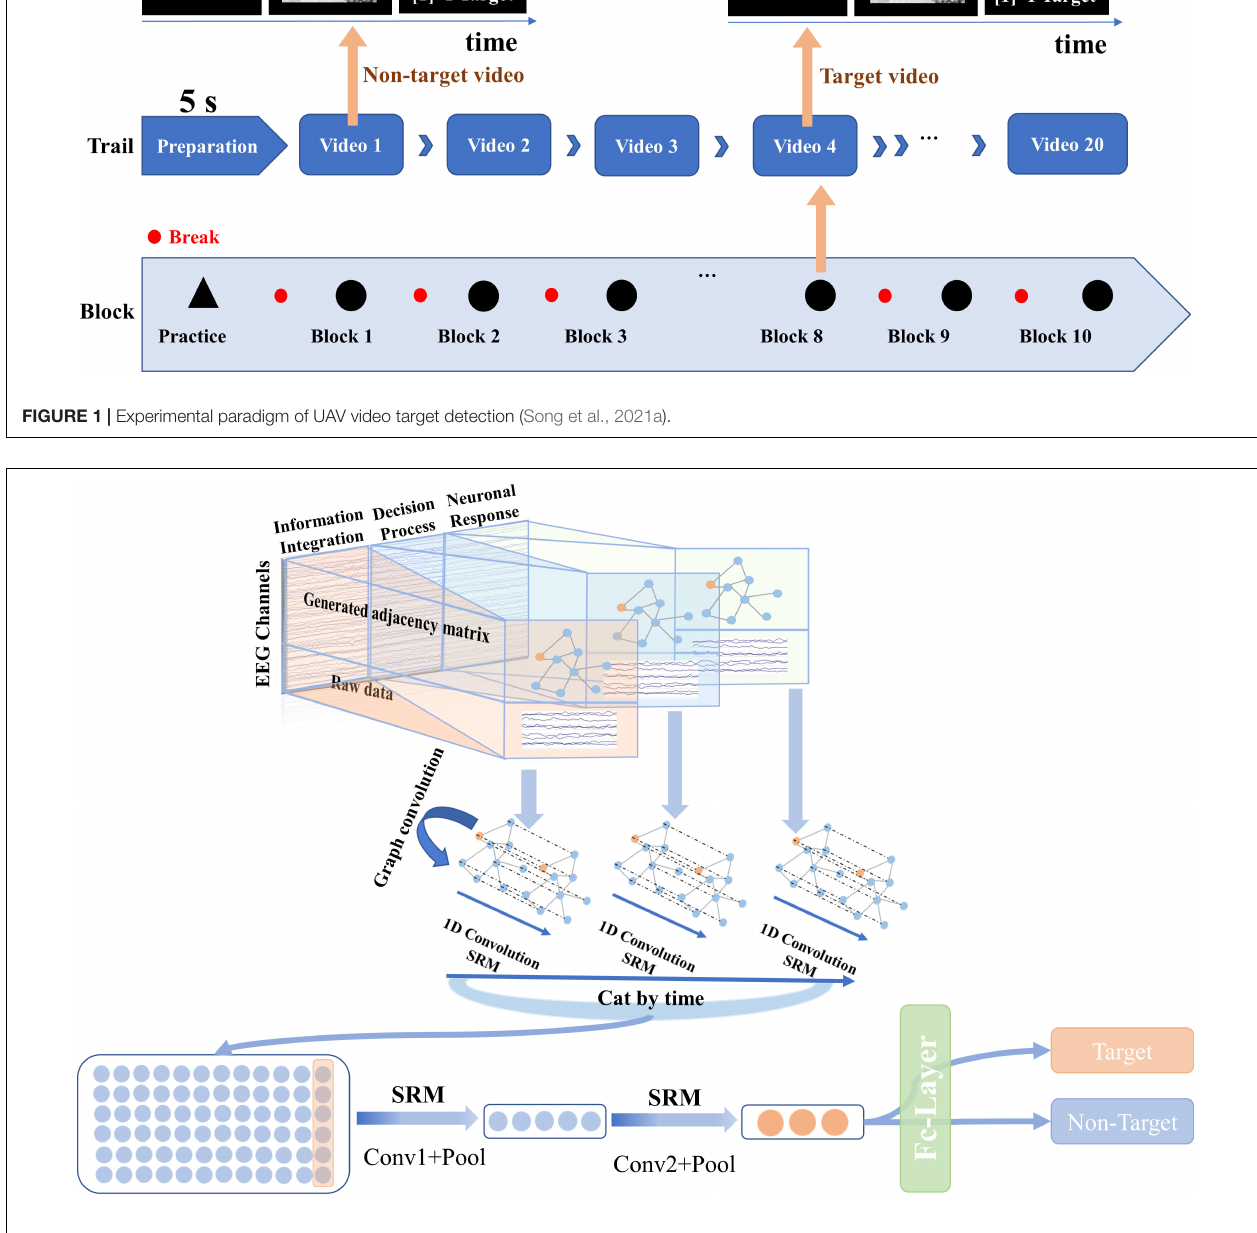
FIGURE 2 | The overall architecture of the proposed SAST-GCN. The model consists of three parts: the segmented adjacent matrix construction module, the spatial-temporal graph convolution module, and the classification